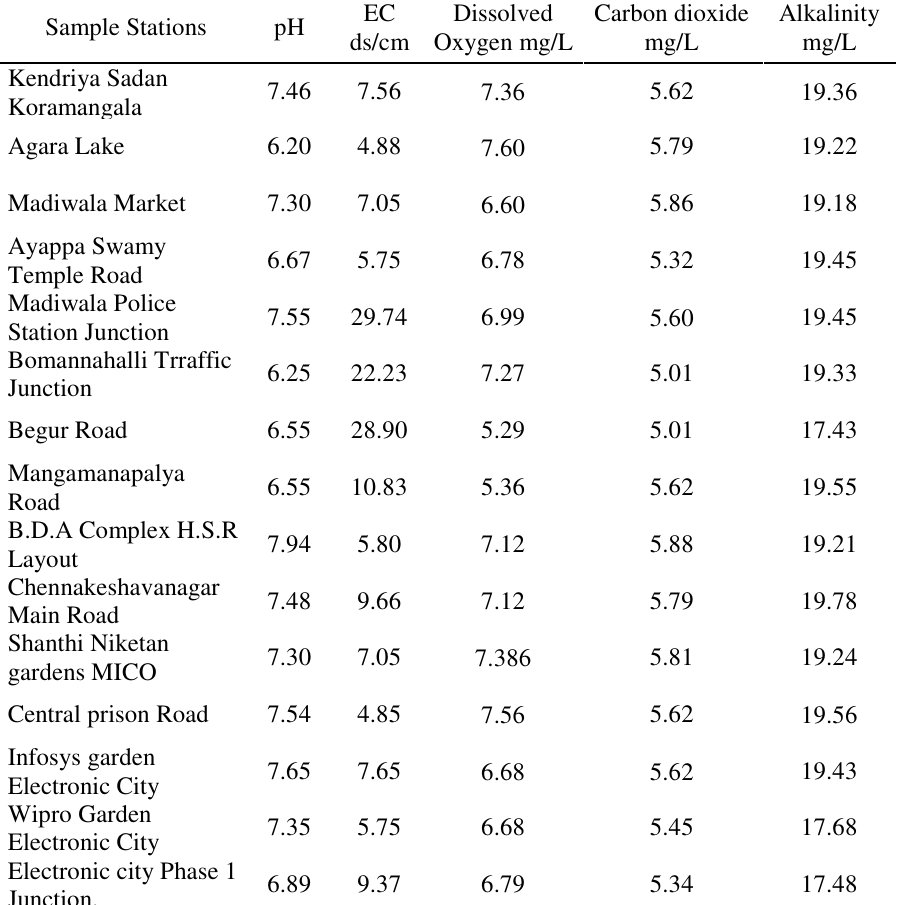
Table 1. Some physicochemical parameters of the soil